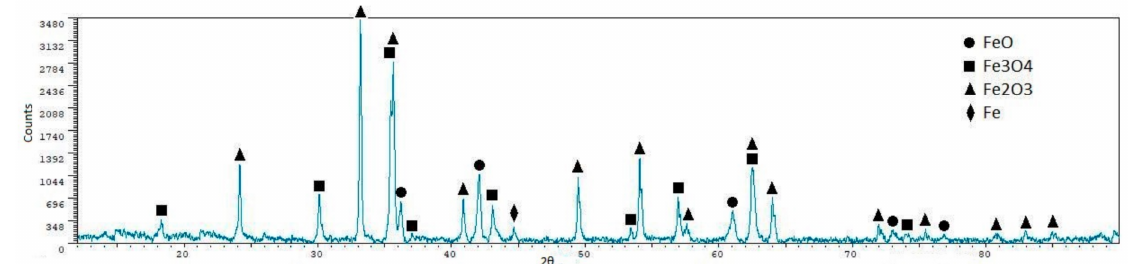
Figure 12. X-ray diffraction diagram for the sample E20P1.